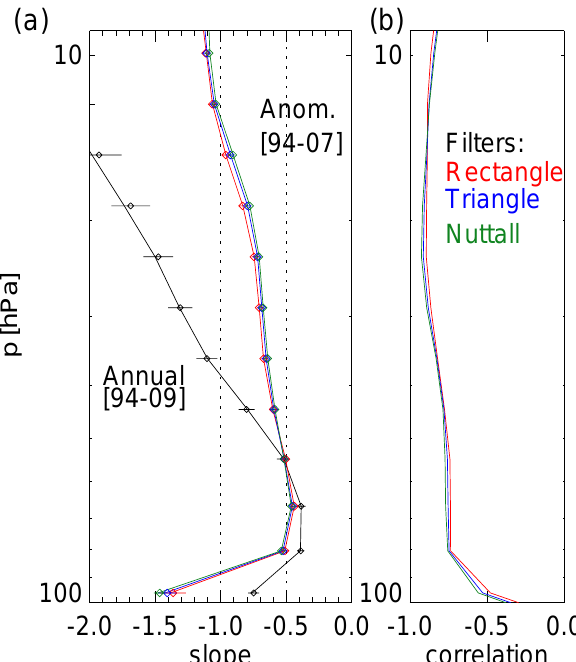
Fig. 8. Temperature correlations tropics-extratropics based on ERA-Interim data at 67hPa. (a) Slope of linear fits (fitted in tropi- cal and combined extratropical temperatures) to the annual (black) and high-pass filtered interannual variability. The colors refer to the filter used for band-pass filtering, filter types as indicated in panel (b) . Dashed lines indicate slopes of − 1/2 and − 1. Error bars and means calculated based on slope distribution calculated from boot- strapping the sample for the mean annual cycle; solid line connects slopes obtained with the original sample. (b) The correlation coeffi- cient of the interannual variability for the period 1994-2007, based on the annual cycle of the period 1994–2009. All filters (rectangle, triangle and Nuttall) use a width of 2 years (24 samples); conse- quently the correlations are calculated for the period